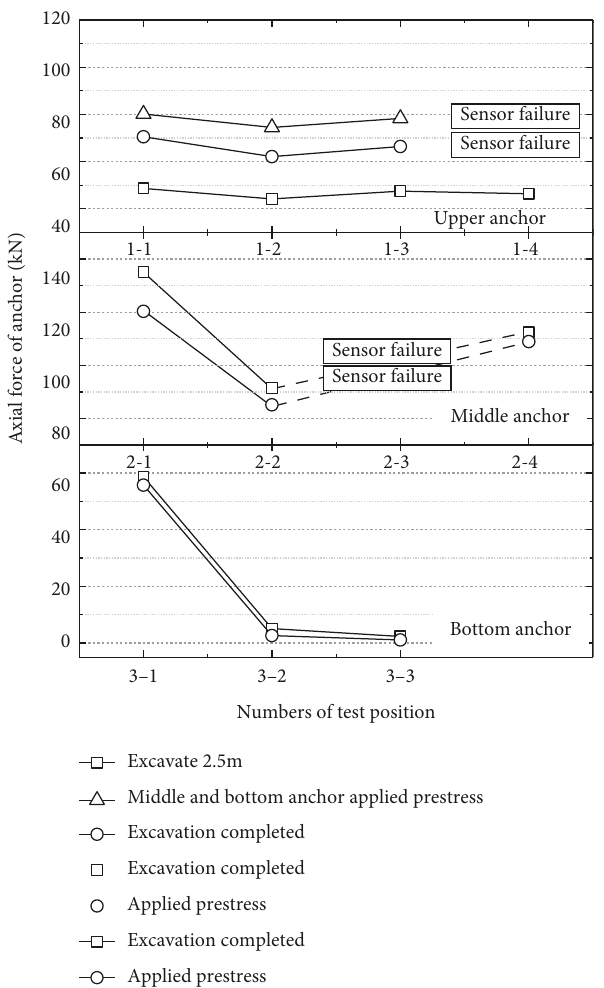
Figure 9: Axial force distribution of each row of anchors under different working